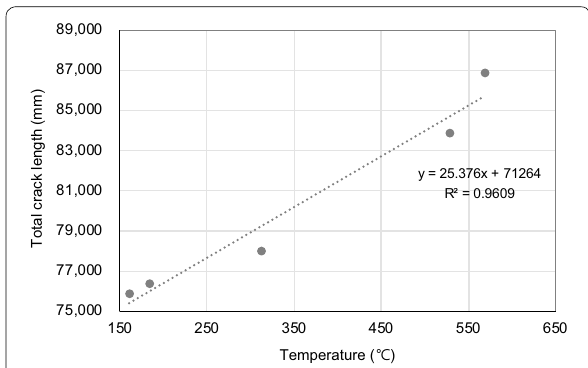
Fig. 12 Correlation between temperatures and total crack lengths obtained from the optical observation.